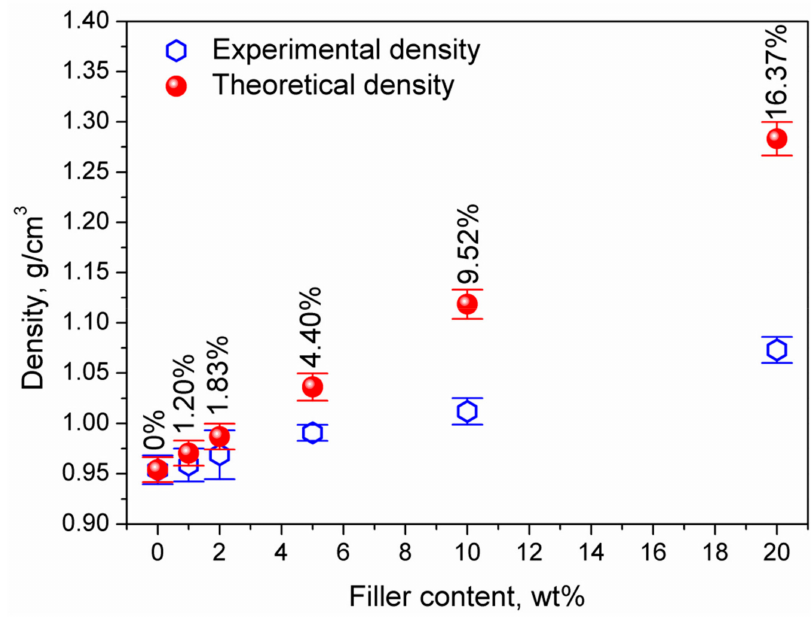
Figure 4. The porosity of the composites as a function of filler